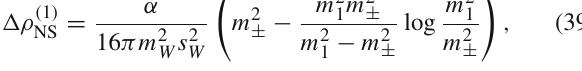
¯ ψ → Z (cid:2) → SM particles and ¯ ψ → Z (cid:2) Z (cid:2) ¯ ψ → Z (cid:2) h 1